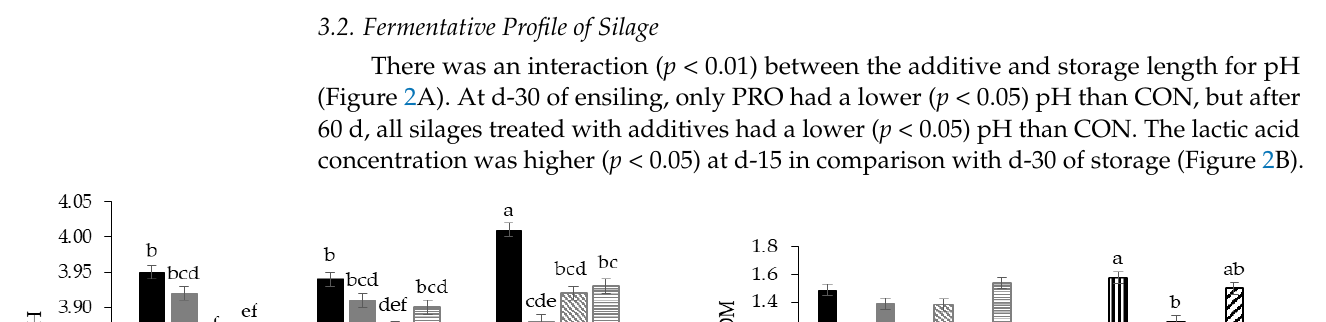
1 Percentage of particles retained in each sieve (DM basis); 2 Effect of additive (A), storage length (S), and the interaction between additive and storage length (A × S). a,b Rows with different letters differ by the Tukey’s test ( p ≤ 0.05).